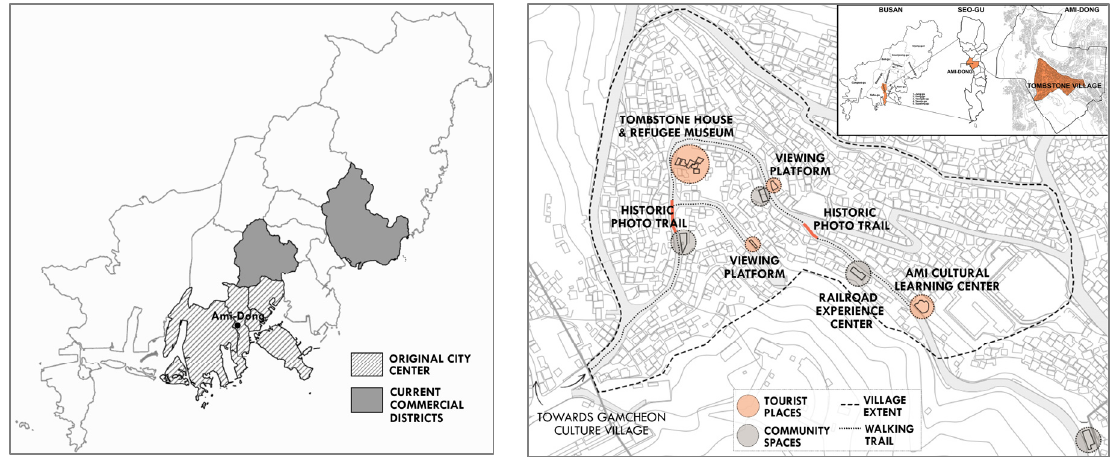
Figure 2. Map of Busan showing the Original City Centre ( Left ), and Location of Ami-dong and places created/re-created between 2013 and 2020 ( Right ).